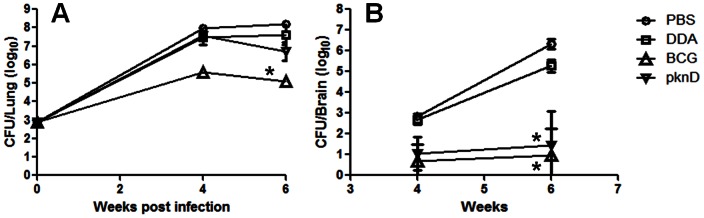
PknD vaccination protects against M.
tuberculosis dissemination to the brain.Colony-forming units (CFU) in the lungs (panel A) and brains (panel B) of guinea pigs vaccinated with BCG (triangle), recombinant PknD (inverted triangle), DDA (adjuvant alone) (square) or PBS (unvaccinated controls) (circle), 4- and 6-weeks after an aerosol challenge with M. tuberculosis are shown. BCG vaccination limited the pulmonary bacillary load (P = 0.01) and also significantly reduced the bacillary burden in the brains after aerosol challenge with virulent M. tuberculosis (P = 0.01). While PknD vaccination did not limit bacillary growth in the lungs, it offered significant protection against bacillary dissemination to the brain, which was no different from BCG (P>0.24), even though the PknD vaccinated animals had almost 100-fold higher bacterial burdens in the lungs. Four guinea pigs per group were sacrificed at each time-point, except for the DDA group, for which only three animals were sacrificed 6-weeks after aerosol challenge. Data are presented on a logarithmic scale as mean±standard deviation.